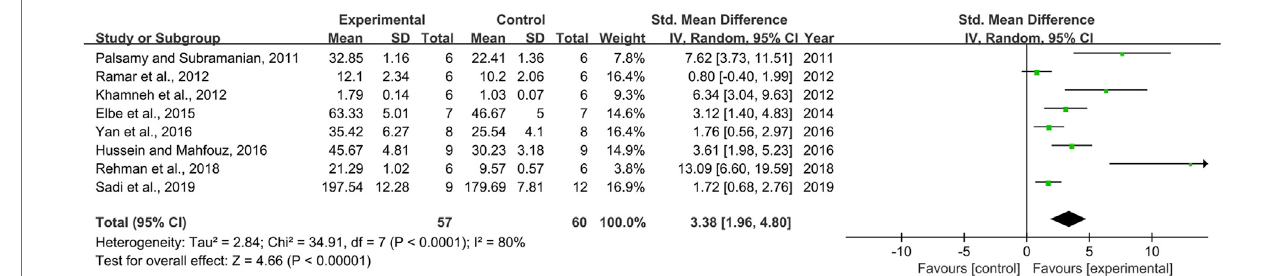
FIGURE 7 | Pooled estimate of CAT with RSV.